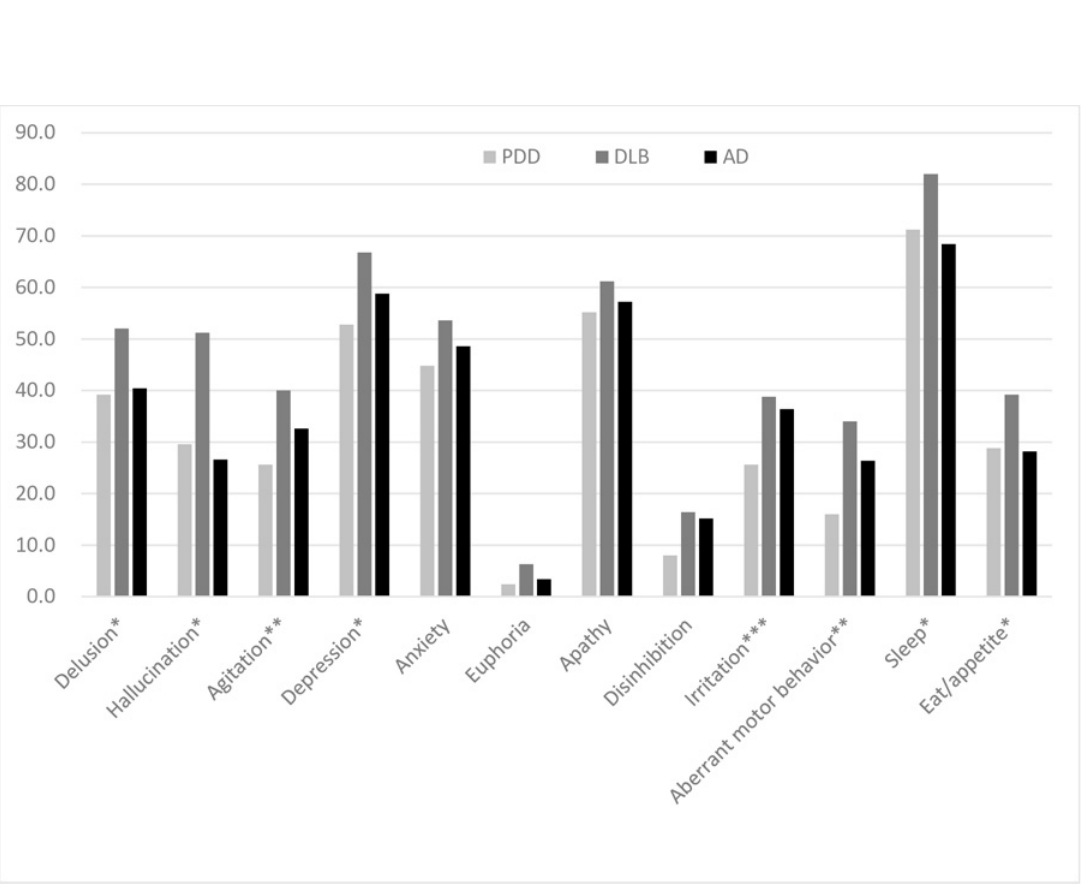
Fig 1. Comparison of the frequency of each item in the NPI among the PDD, DLB and AD groups adjusted for gender and use of antipsychotics. * PDD = AD < DLB; ** PDD < AD < DLB; *** PDD < AD =